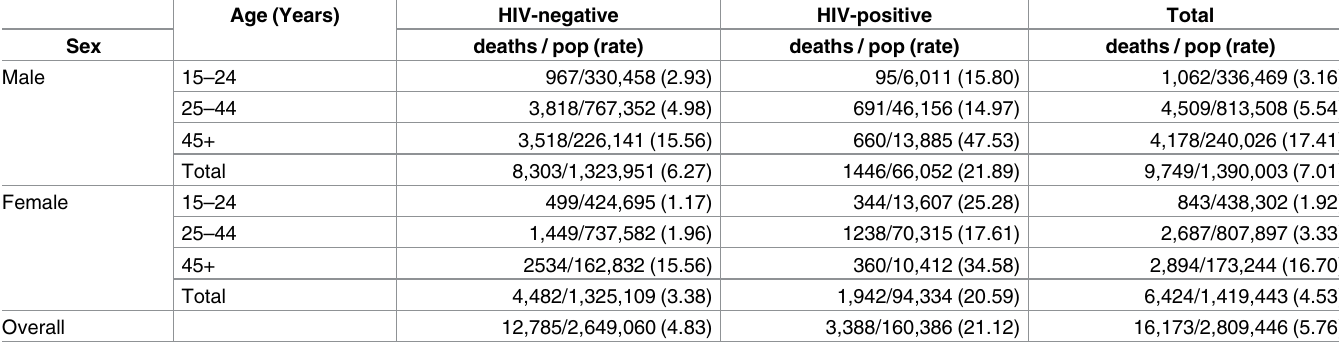
Table 3. Estimated age- and sex-specificdeaths, population, and mortality rates per 1000 population, Nairobi